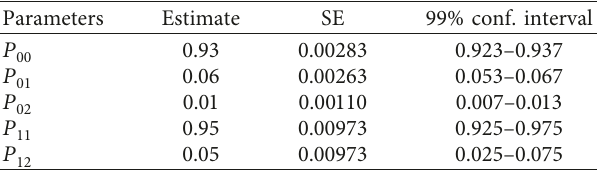
Table 5: ML estimates of transition probabilities for HIV.